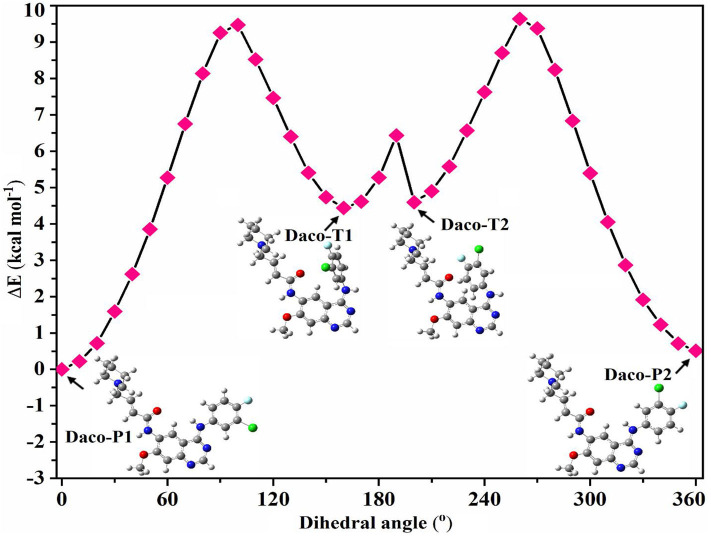
Potential energy surface (PES) scan of Dacomitinib conformers in DMSO through local rotation of the C(17)-N(5) bond (dihedral angle ∠N(7)-C(17)-N(5)-H) using the B3LYP/6-311G level of theory. Pointed arrows at a particular point on PES refer to the corresponding 3D structures of Dacomitinib. In the 3D structures of Dacomitinib conformers, atoms of carbon, hydrogen, nitrogen, oxygen, chlorine, and fluorine are denoted by gray-, white-, blue-, red-, green-, and cyan-colored atoms, respectively.